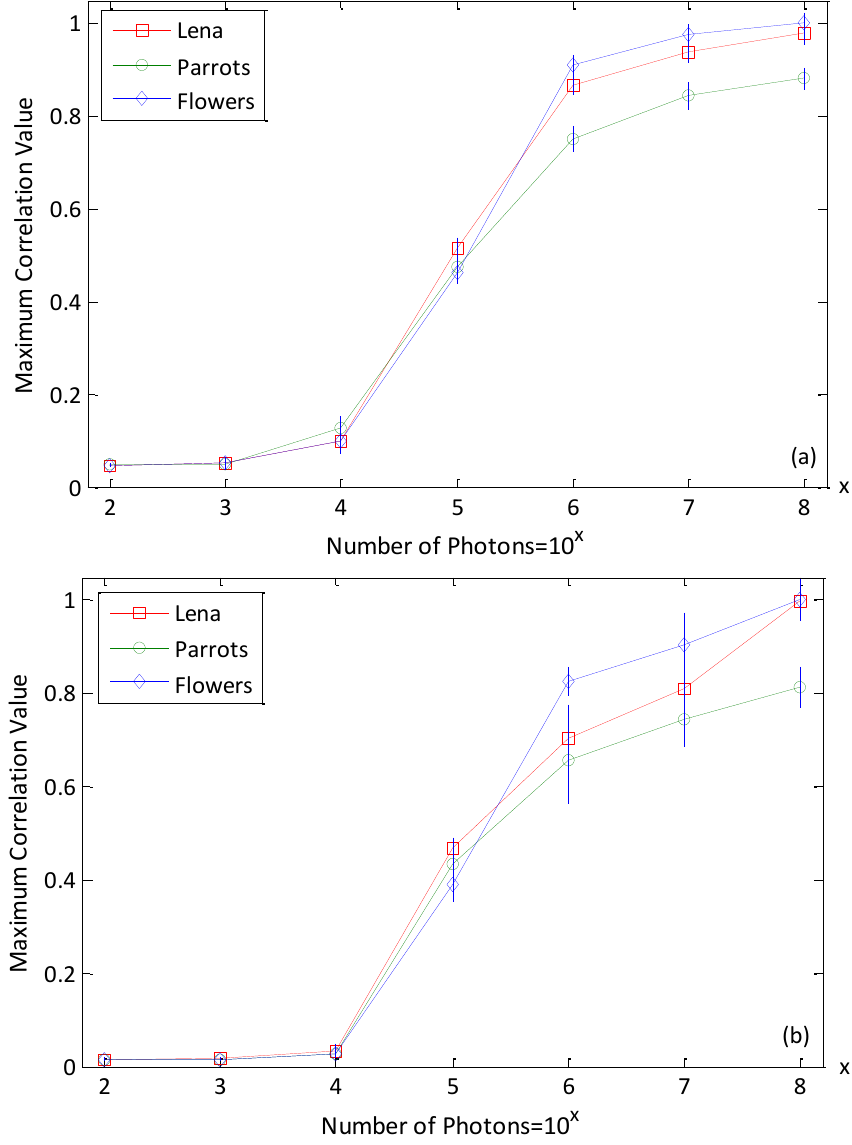
Figure 8. ( a ) The maximum correlation values between reference and decrypted true-class Bayer images; ( b ) The maximum correlation values between reference and decrypted demoasicing RGB true class images. (Error bars represent ±1 standard deviation of the 50 times measurement, k =